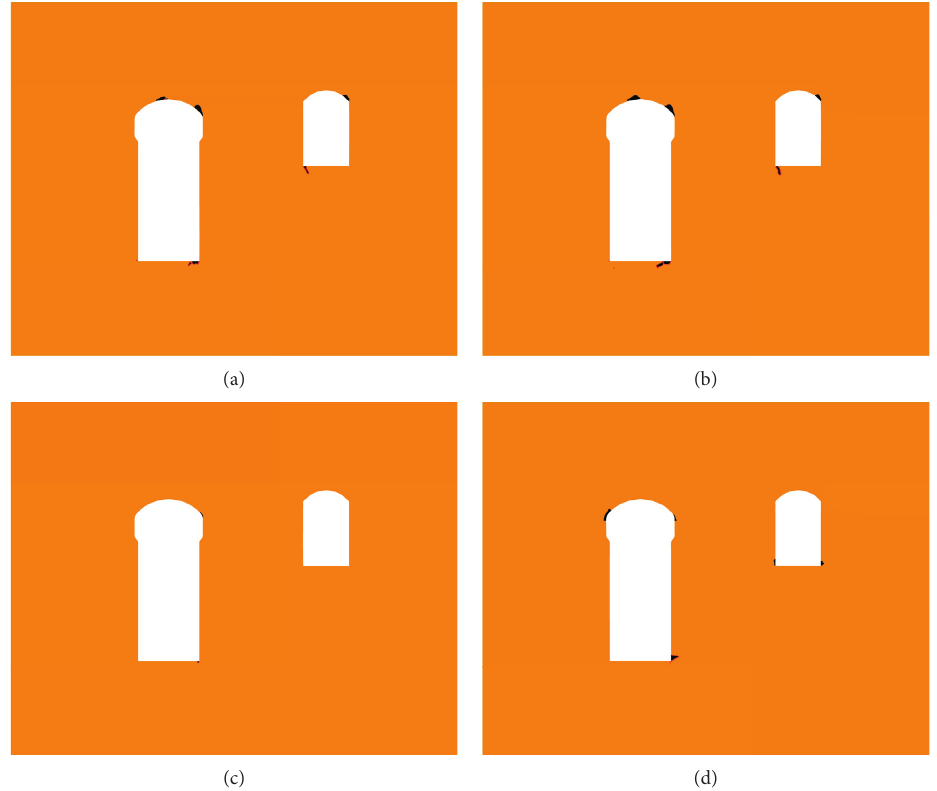
Figure 17: Damage zone of the underground powerhouse based on four criteria. (a) LEE. (b) NLEE. (c) Pariseau ( n � 1). (d)